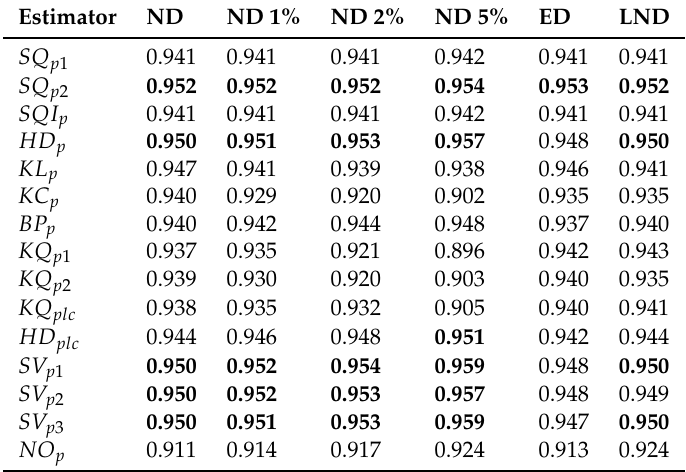
Table 4. Coverage probabilities for nonparametric Limits of Agreement ( n = 100). Bold figures indicate coverage probabilities exceeding the nominal level of 0.95.